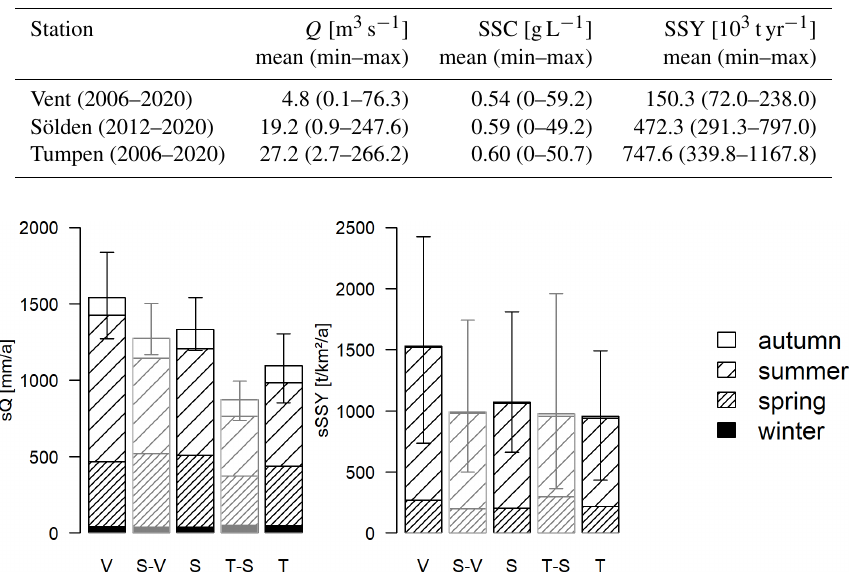
Figure 3. Mean annual specific discharge ( sQ ) and suspended sediment yields ( s SSY) at the gauges in Vent, Sölden and Tumpen as well as the intermediate catchments between gauges in Vent and Sölden (S-V) and between gauges in Sölden and Tumpen (T-S). Bars are divided into and maximum annual